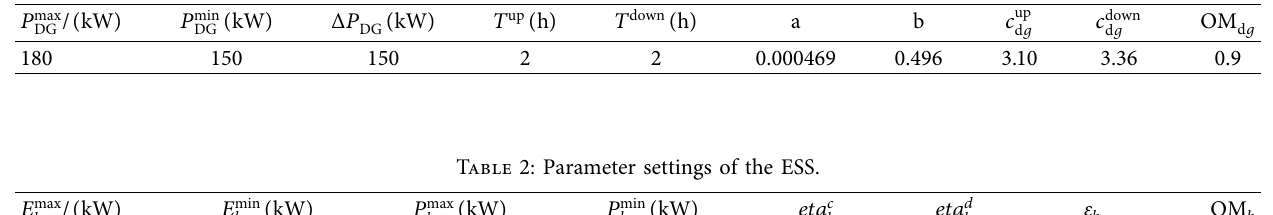
Table 1: Operating parameters of the DGs.